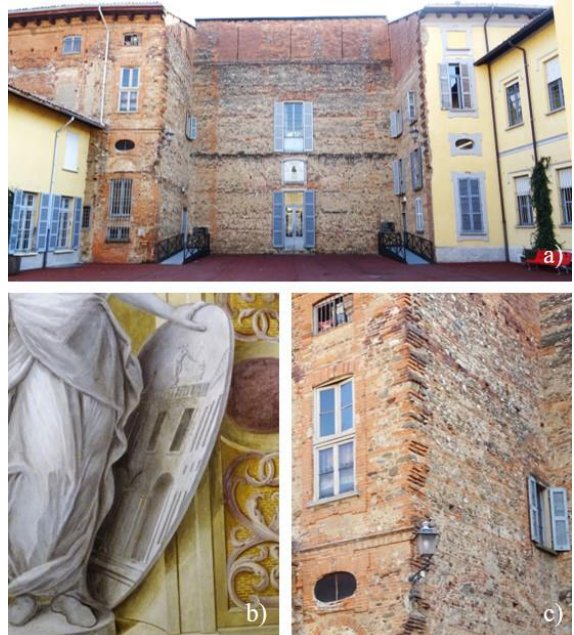
Figure 6. Trotti Palace: a) main courtyard with the incomplete side; b) the representation of the courtyard in a fresco at the ground floor and c) detail of a connection for the